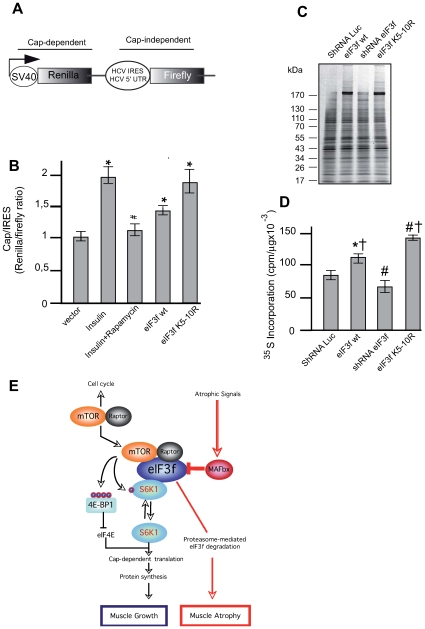
eIF3f regulates cap-dependent translation.(A) Structure of the bicistronic reporter plasmid allowing
cap-dependent expression of renilla luciferase and expression of firefly
luciferase dependent on HCV IRES. (B) Overexpression of
eIF3f modulates cap-dependent translation. Mouse primary cultured
satellite cells were cotransfected with the bicistronic reporter vector
and expression vectors encoding HA-tagged eIF3f wt and the mutant eIF3f
K5–10R. Twenty-four hours posttransfection
cells were grown for an additional 24h in 20% serum
(control), stimulated with insulin or pretreated with rapamycin and
stimulated with insulin for and additional 24 h. Cells transfected to
express eIF3f wt or the mutant eIF3f K5–10R were
grown in 20% serum. Luciferase activities were measured by a
dual-luciferase assay. The ratio of Renilla (Cap-dependent) to Firefly
(IRES-dependent) luciferase activity was calculated. Data are presented
as the mean ± standard error from three independent
experiments carried out in triplicate,
*P<0,05 compared to control;
#
P<0,05 compared to Insulin
+ rapamycin. (C) Mouse primary cultured satellite
cells were transfected with expression vectors as described in (B)
and/or subjected to shRNAi-mediated silencing of eIF3f prior to labeling
new protein synthesis with 35S methionine. Newly synthesized
proteins were separated by SDS-PAGE, and visualized by autoradiography.
(D) Newly synthesized proteins from three experiments
as in (C) were quantified.
*P = 0,002 and
#
P<0,001 compared to control;
†
P>0,001 compared to
shRNAi eIF3f. (E). Model depicting the central
role of eIF3f in the signaling pathways controlling skeletal muscle
mass.